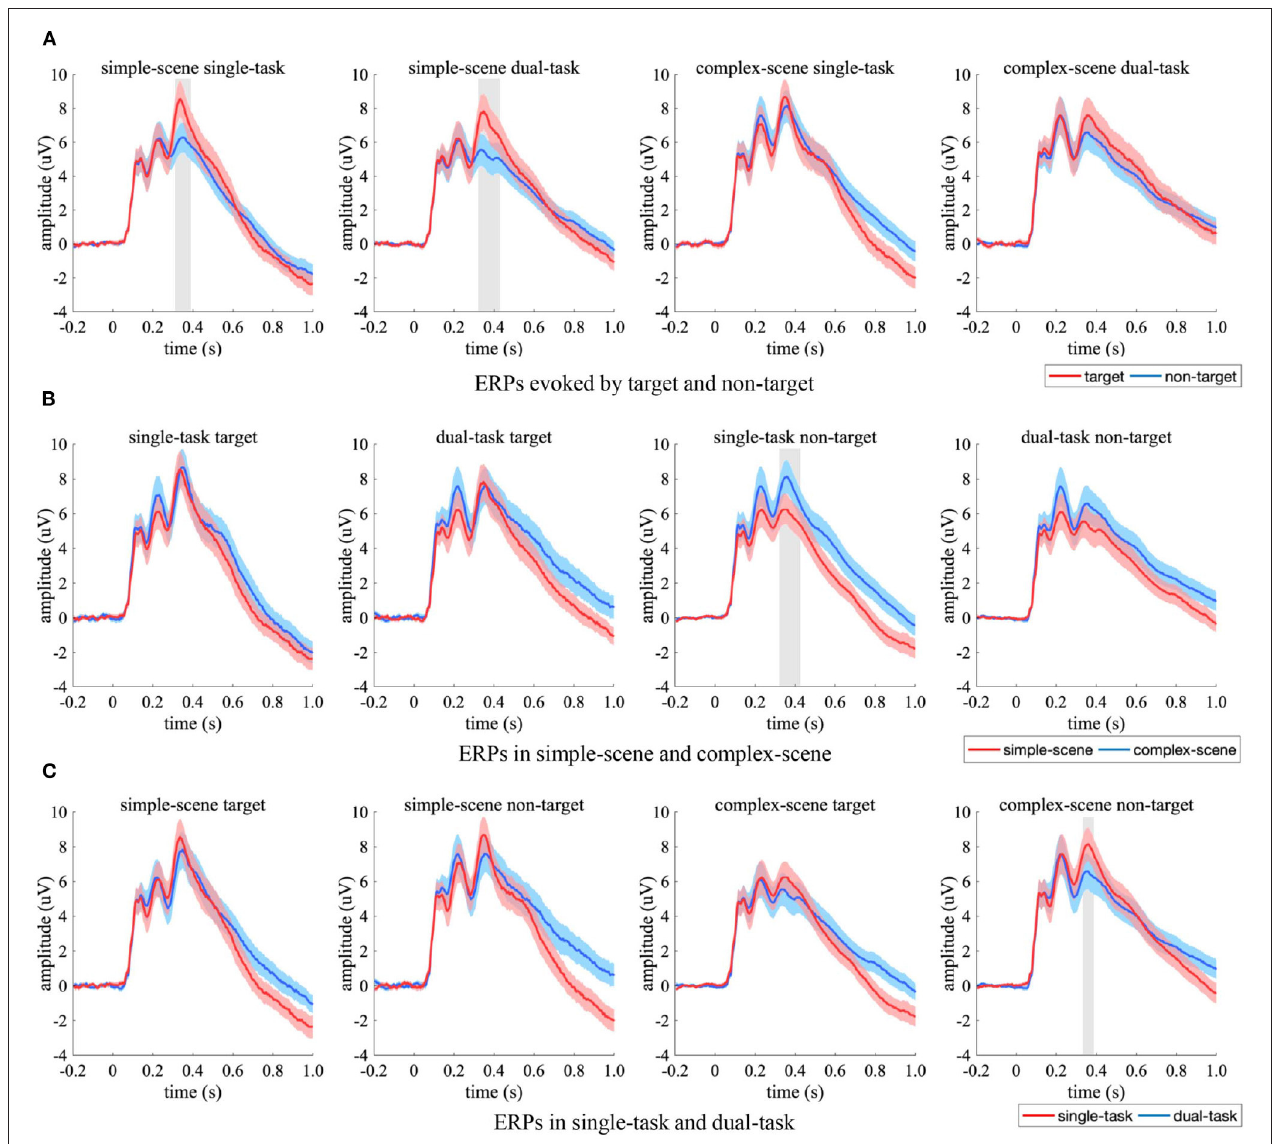
FIGURE 6 | Comparison of ERPs in the occipital EEG electrodes. (A) ERPs evoked by target (red) and non-target (blue), (B) ERPs in simple-scene (red) and complex-scene (blue), (C) ERPs in single-task (red) and dual-task (blue). The shaded area indicates 95% confidence interval. Shaded gray regions denote the time intervals where there are significant differences between the two conditions ( p < 0.05, two-sample t -test, FDR